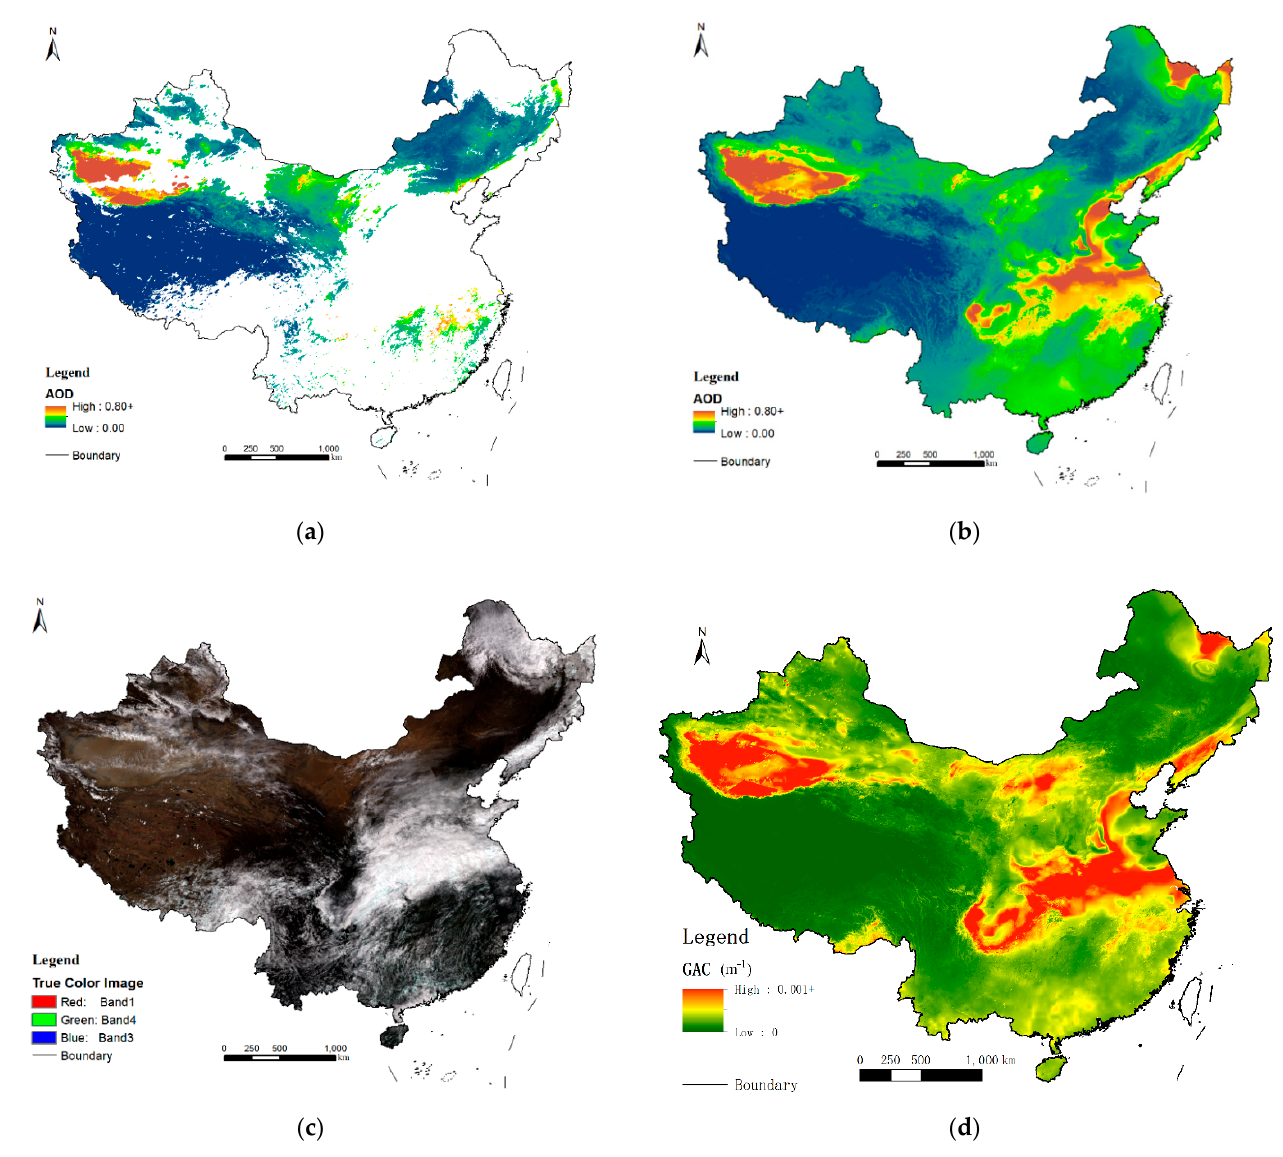
Figure 11. Imputation of MAIAC AOD for an autumn day (1 October) of 2017: original AOD ( a ), complete AOD ( b ), MAIAC ground reflectance of true color ( c ) and GAC ( d ).